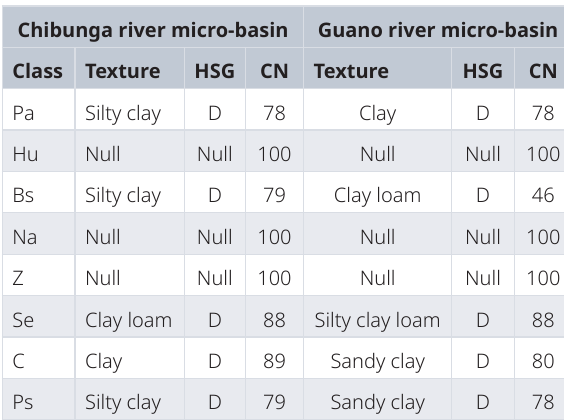
Table 3. Assignment of hydrological group (HSG) and curve number (CN) for the Chibunga and Guano river